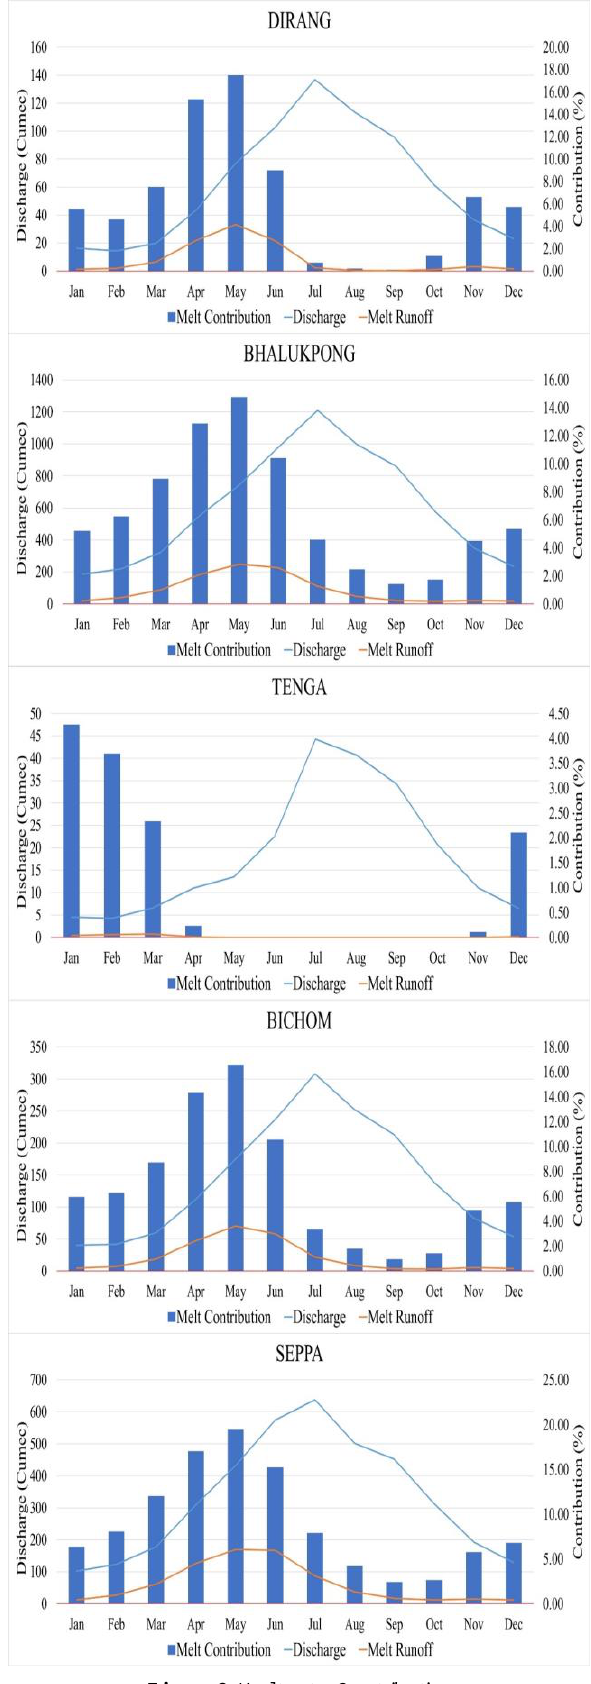
Figure 6 . Meltwater